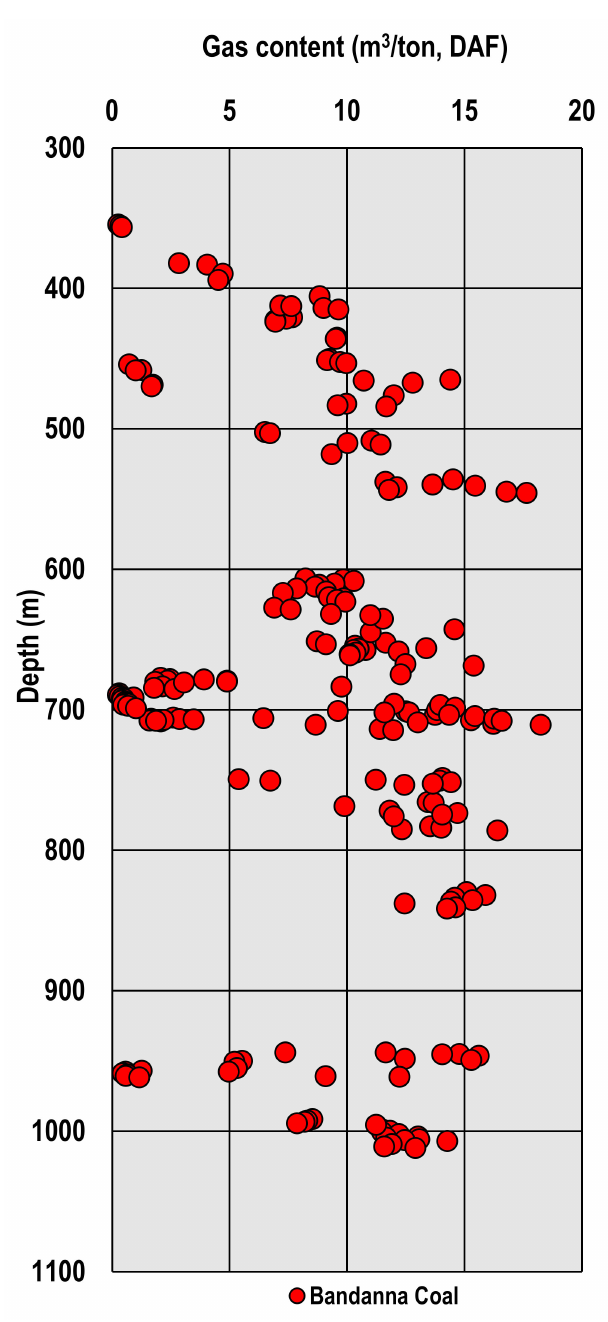
Figure 9. Gas content versus depth for the Bandanna Coals of the Bowen Basin. Variability in gas content is observed across the field (data sourced from Queensland Government